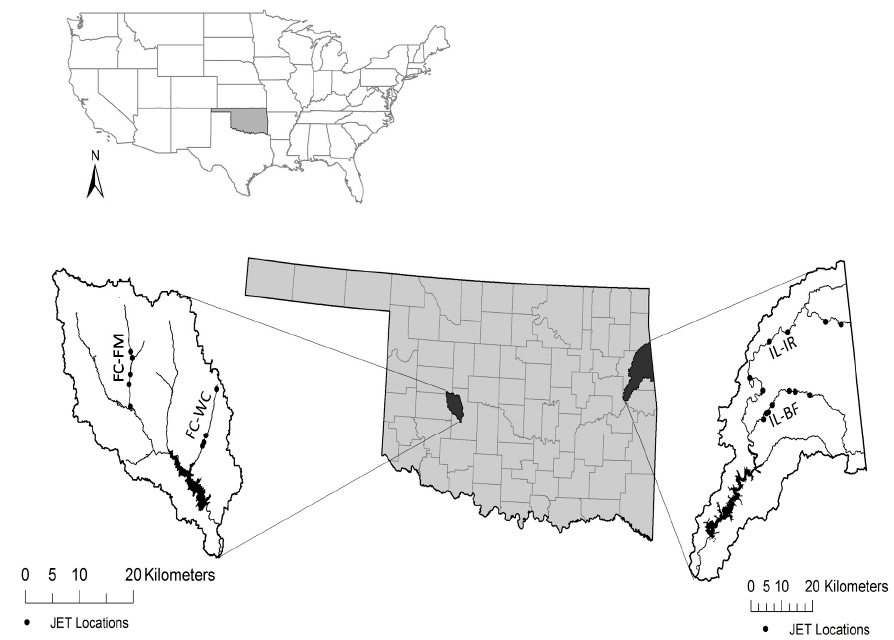
Figure 1. Selected field data collection sites along Fivemile (FC-FM) and Willow Creeks (FC-WC) in the Fort Cobb (FC) Reservoir Watershed and the Illinois River (IL-IR) and Barren Fork Creek (IL-BF) in the Illinois River (IR) Watershed.